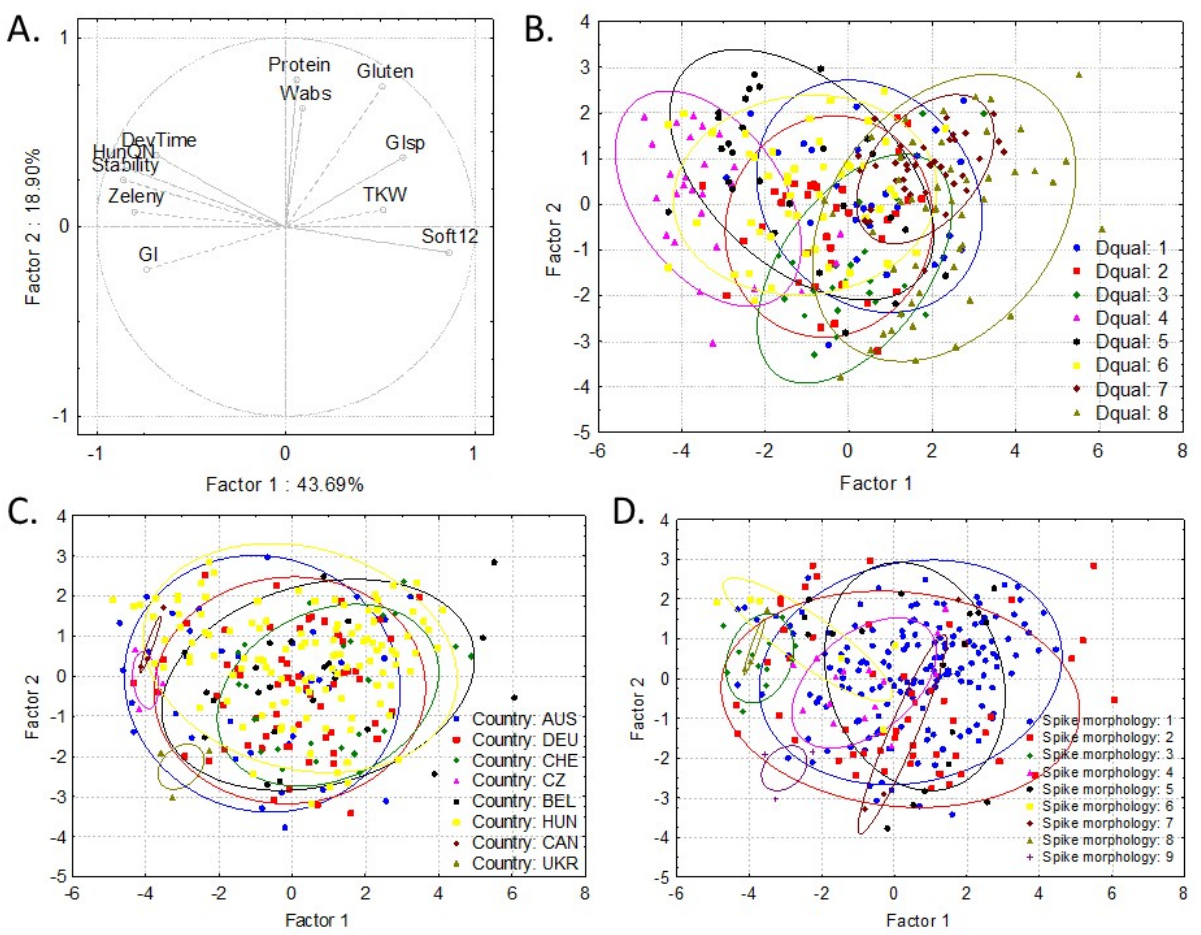
Figure 3. Principal component analysis based on the breadmaking quality traits and including protein and gluten content and TKW of spelt ( A ) and grouped by the groups formed by the hierarchical cluster analysis ( B ), country ( C ), and spike morphology ( D ) groups (where the most determinant traits contributed to Factor 1 was dough stability ( − 0.8591), dough softening (0.8607), farinograph quality number ( − 0.8674), and Zeleny sedimentation ( − 0.8019), while it was protein content (0.7798), gluten content (0.7416), and water absorption (0.6277) to Factor 2). DevTime, dough development time; GI, gluten index; Glsp, gluten spread; HunQN, farinograph quality number; Soft12, farinograph dough softening at 12 min; stability, farinograph dough stability; TKW, thousand kernel weight; Wabs, water absorption of the flour; Zeleny, Zeleny sedimentation; Dqual, quality groups on dendrogram (Figure 2a); AUS, Australia; BEL, Belgium; CAN, Canada; CHE, Switzerland; CZ, Czech Republic; DEU, Germany; HUN, Hungary; and UKR, Ukraine. Spike morphology: (1) awnless, red, spelt-type spike; (2) awnless, white, spelt-type spike; (3) awned, black, spelt-type spike; (4) awned, red, spelt-type spike, (5) awned, white, spelt-type spike; (6) awnless, gray, spelt-type spike; (7) awnless, gray, wheat-type spike; (8) awnless, white wheat; and (9) awned, white wheat.